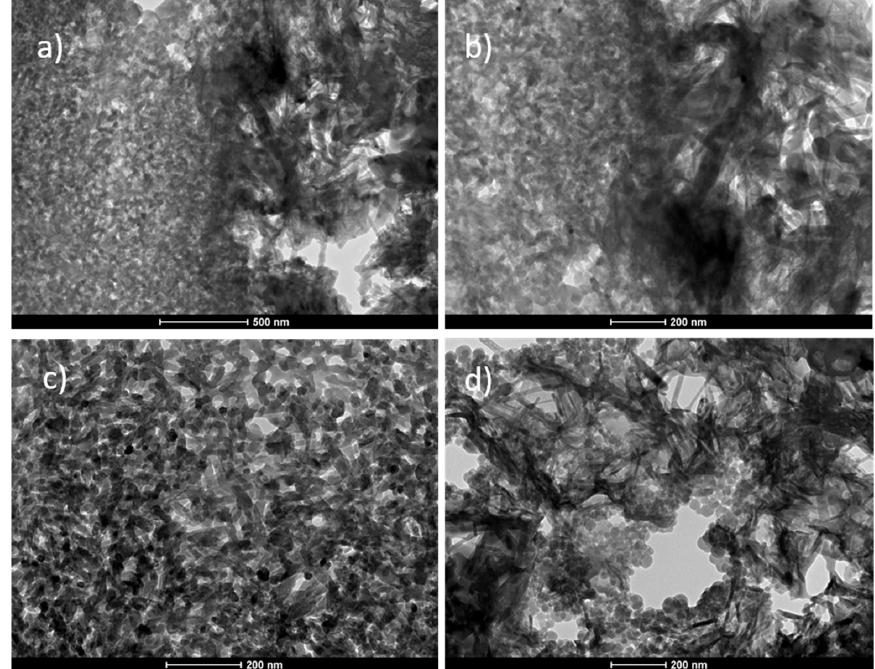
Figure 4. TEM/BF microphotographs of the HT composite presenting: matrix/granule interface ( a , b ), and the microstructure of the hybrid granule ( c ) and calcium-phosphate matrix ( d ).